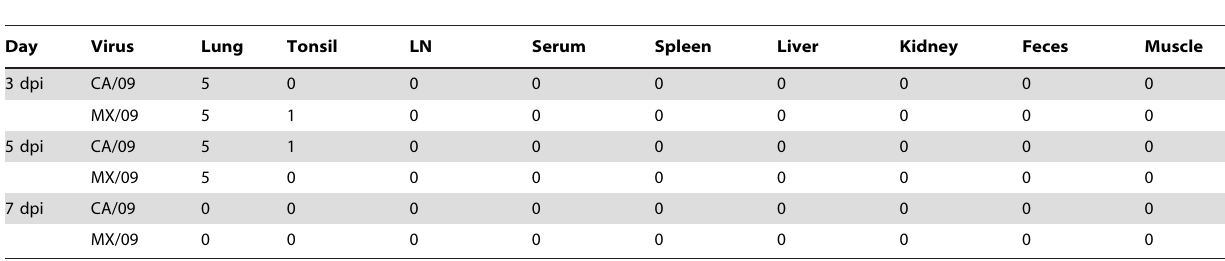
Table 1. Presence of pandemic H1N1 influenza virus by virus isolation in samples collected at 3, 5, and 7 days post infection (dpi). *